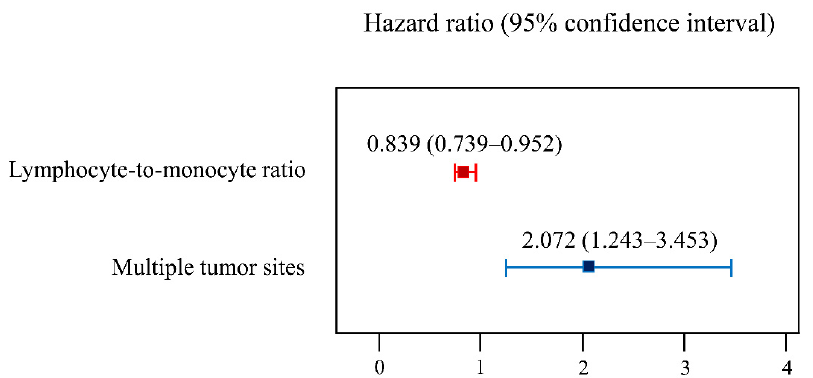
Figure 2. A forest plot of the multivariate Cox regression analysis to evaluate the predictors of the five-year recurrence of non-muscle invasive bladder tumor.